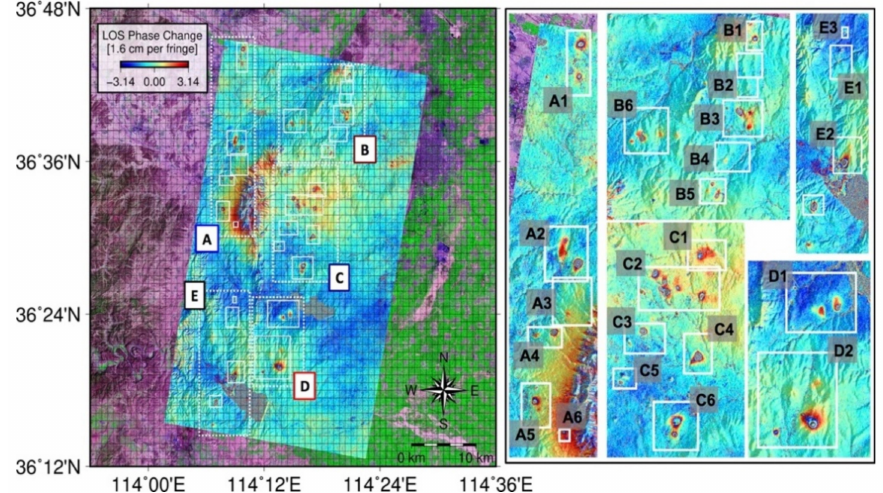
Figure 4. The deformation map of the mining areas estimated by two TerraSAR-X images with a 22-day revisit